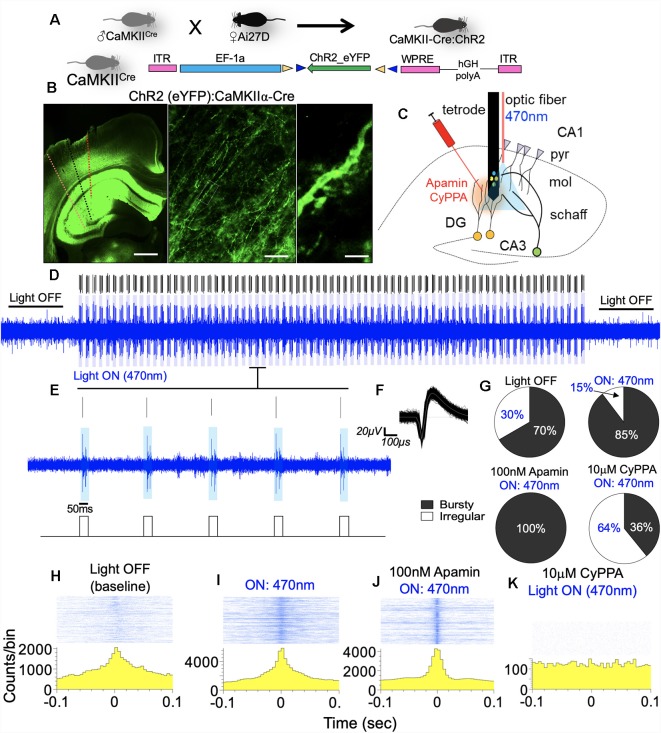
SK channel modulation of CA1 burst discharge. (A) Schematic illustration of a double floxed AAV-ChR2-eYFP expression in CaMKIIα-Cre hippocampus. (B) Reporter eYFP—fluorescence in the hippocampus of CaMKII-Cre:ChR2 mouse. (C) Schematic illustration of an experimental set up depicting the relative position of the optic fiber, drug injection, and recording electrode shank (pyr, pyramidal layer; mol, molecular layer; schaff, schaffer collateral). Scale bar = 0.5 mm, 50 μm, 5 μm. (D,E) Spike train with adjoining rasters demonstrating 470 nm LED light pulse (50 ms) at 1 Hz. (F) Sample waveform for spikes generated by optogenetic stimulation of CA1 neuron units. (G) Pie chart representing ISI histogram characterization of neurons based on firing properties. (H–K) Sample perievent histogram demonstrating rhythmicity of neuronal population during photostimulation, and when paired with SK channel modulation in vivo.